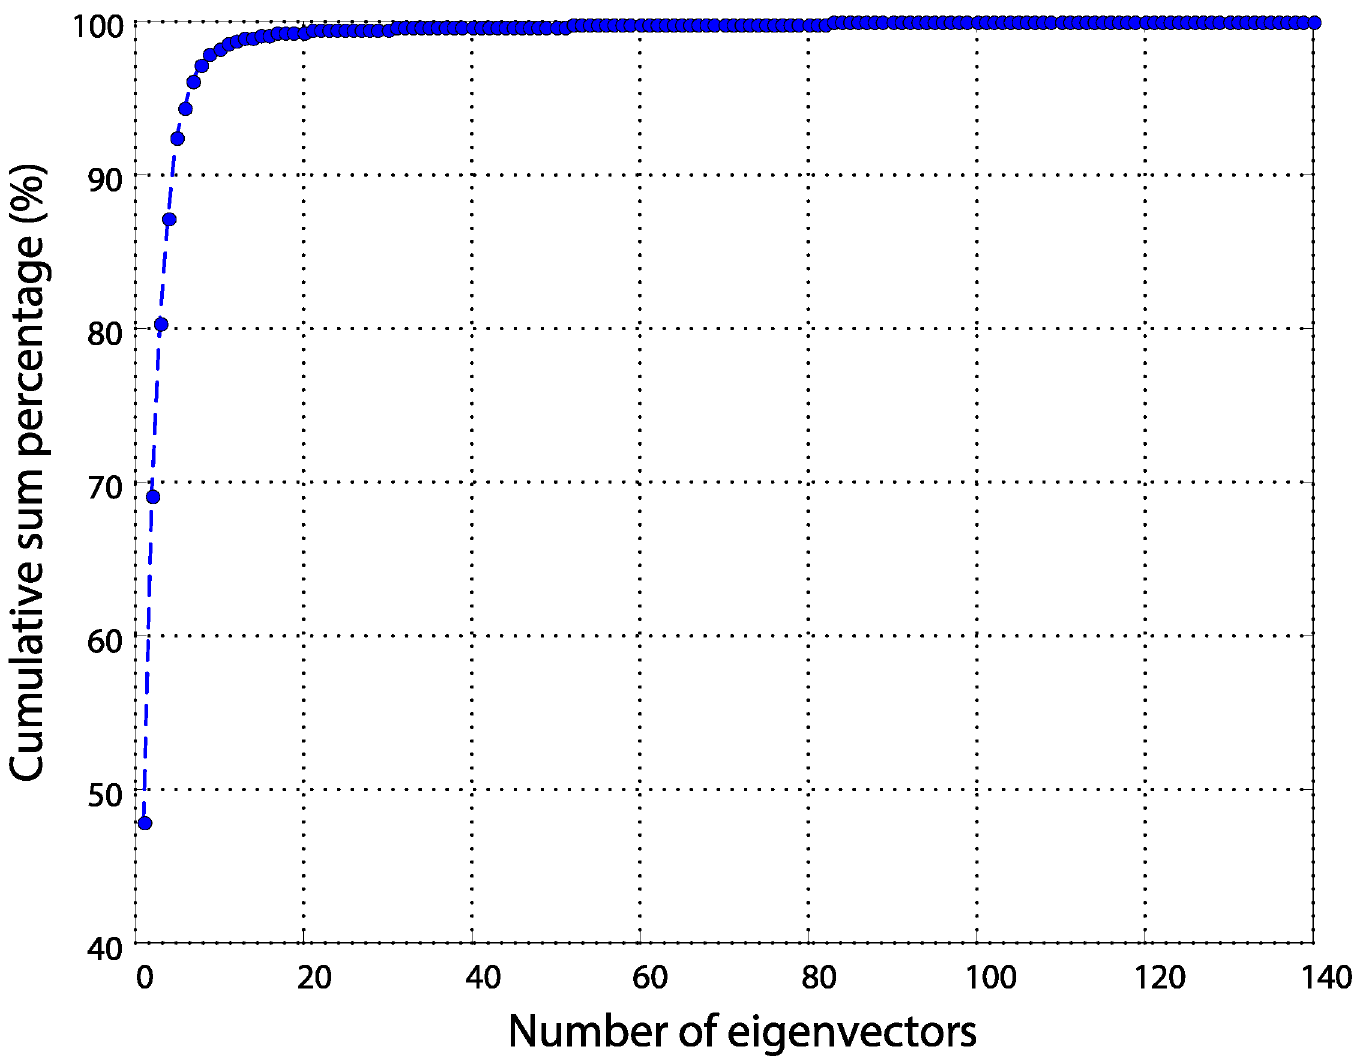
Fig 2. Cumulative sum percentage of eigenvalues after sorting the eigenvalues of the scatter matrix of e-nose data samples in descending order.